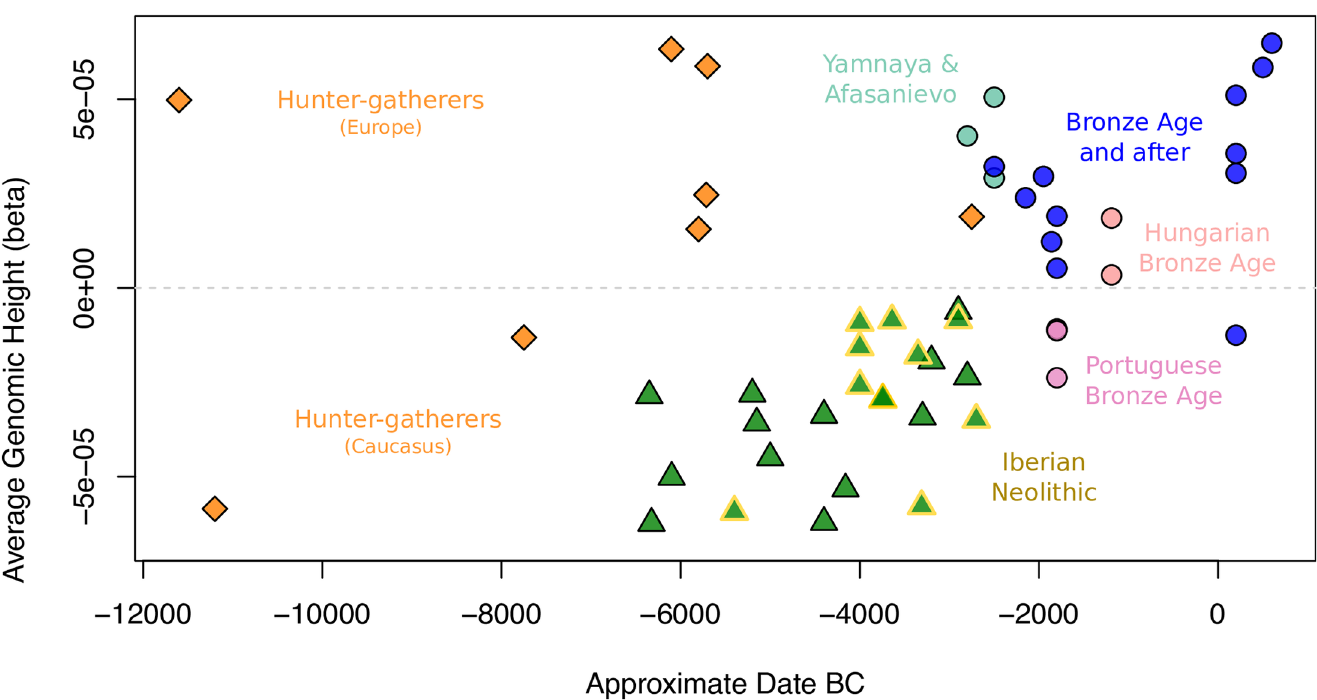
Fig 5. Average genomic height for each of the Western Eurasian samples in the imputed dataset, plotted against its approximate date, highlighting temporal trends in genetic height. We excludedfrom this analysisRussian Bronze and Iron Age individuals containingvariable amounts of Siberianadmixture, but polygenic scores for all imputedsamples can be seen in S7 Text.